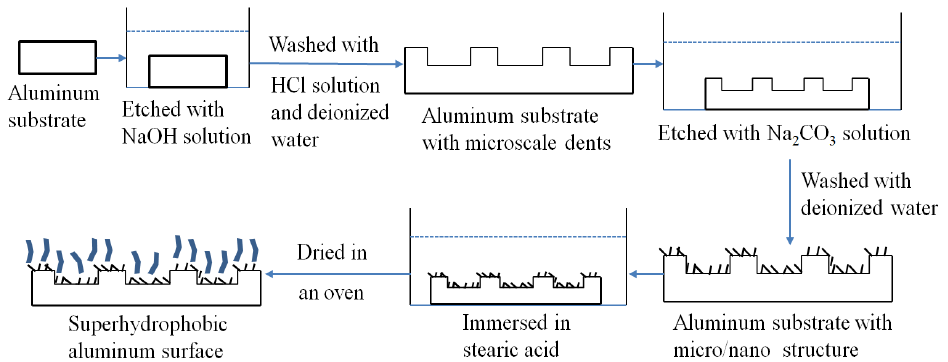
Figure 1. Schematic diagram for preparing superhydrophobic 2024 aluminum alloy surface.